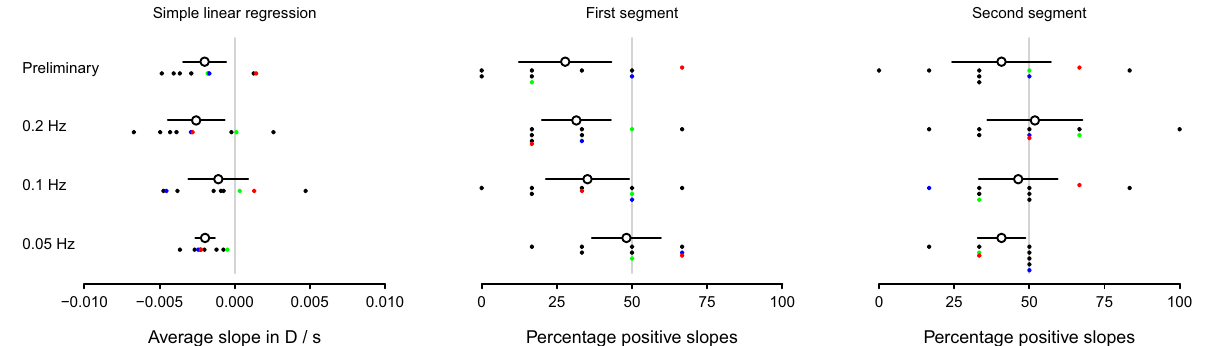
Figure 4. Linear and segmented regression analyses of amplitude. The open circles in the left panel show the average slope estimates in amplitude of accommodation over trials of the preliminary condition and of the 3 optical-blur conditions for moving stimuli at 0.05 Hz, 0.1 Hz, and 0.2 Hz from simple linear regression. The individual slope estimates for each observer are represented as solid black circles, except for the three observers in the supplemental material showcasing a good accommodator, an average accommodator, and a poor accommodator which are represented by solid green, blue, and red circles respectively. The open circles in the middle and right panels show the average percentage of times the slope was positive for, respectively, the first and second regression segments. The individual percentages for each observer are represented as solid black circles, except for the good, average, and poor accommodators in the supplemental material, which are represented by solid green, blue, and red circles respectively. All solid black lines represent the 95% confidence intervals, each with lengths 2 times 1.96 times the standard error of the mean over all 9 observers for each condition.